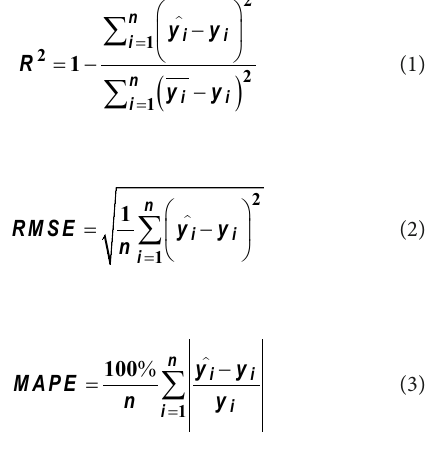
mean square error (RMSE) and mean absolute percentage error